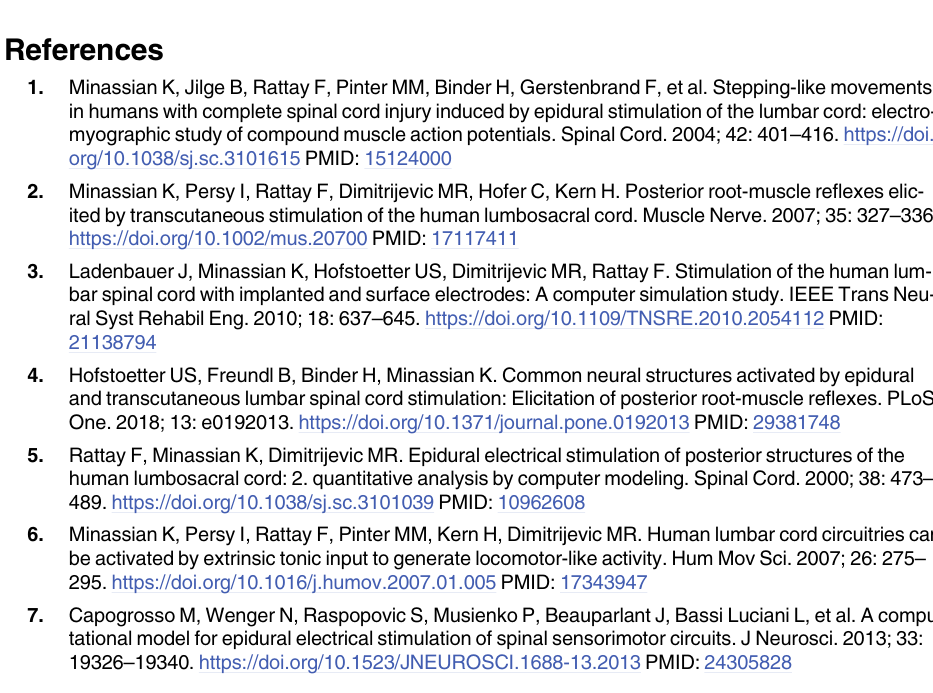
S2 Table. Mean normalized peak-to-peak amplitudes ± SE of PRM reflexes of biceps femo- ris, tibialis anterior and soleus, respectively, at conditioning-intervals exhibiting signifi- cant differences between subject groups along with p-values of Bonferroni-adjusted post- hoc pairwise comparisons. S3 Table. Mean normalized peak-to-peak amplitudes ± SE of PRM reflexes of rectus femo- ris (RF), biceps femoris (BF), tibialis anterior (TA) and soleus, respectively, derived from neurologically intact participants and individuals with spinal cord injury at conditioning- test intervals exhibiting significant differences between muscles along with p-values of Bonferroni-adjusted post-hoc pairwise